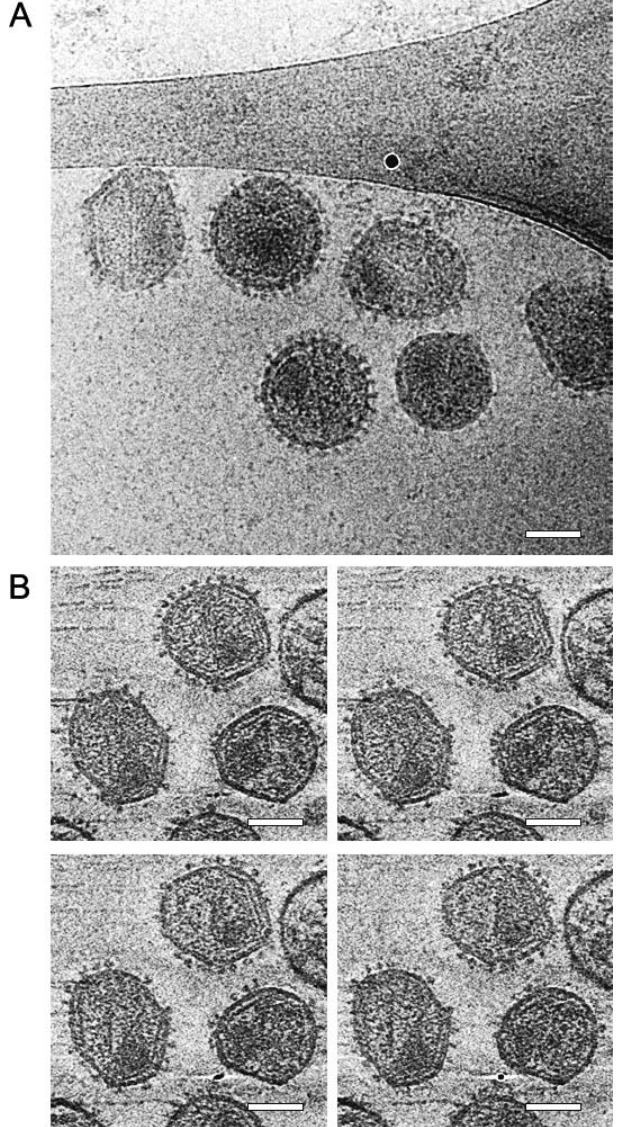
Figure 1. Analysis of Purified SIV Virions by Cryo-Electron Tomography (A) Low-dose projection image of a plunge-frozen specimen. (B) A series of images recorded over a tilt range of (cid:2) 63 8 to þ 63 8 was used to reconstruct a 3-D volume of vitrified viruses similar to those shown in (A). Four 1-nm-thick tomographic slices at different depths from a tomogram of plunge-frozen SIV virions are shown. Scale bars are 50 nm long. The dark black spots are from 5-nm-wide gold fiducial markers used for aligning individual images in a tilt series.